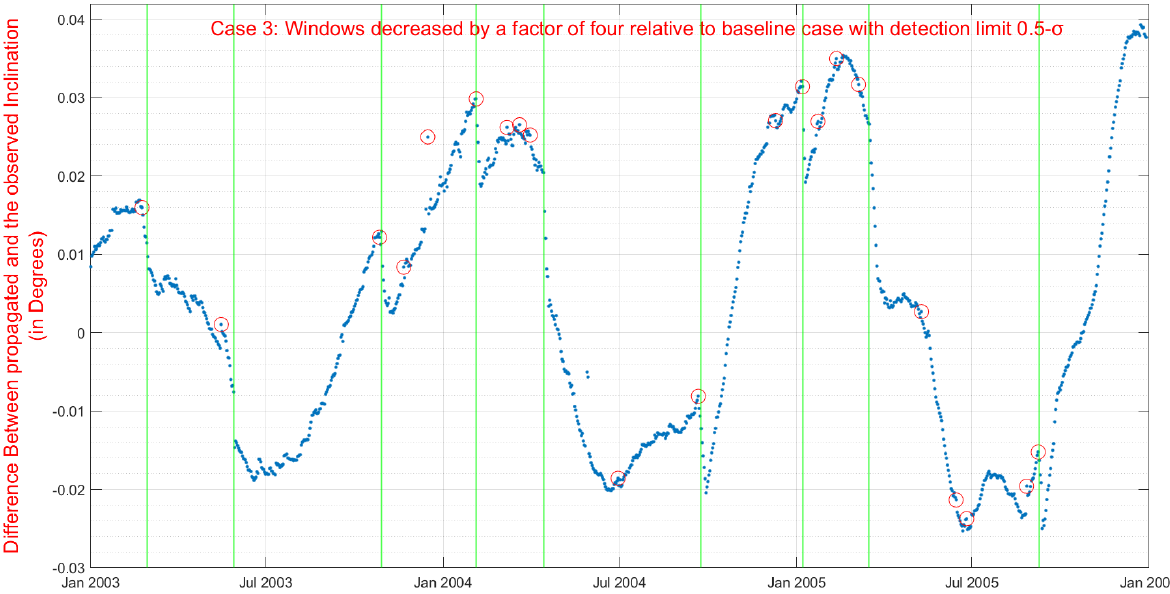
Figure 6. Case 3: Windows decreased by a factor of four relative to baseline case with detection limit 0.5-sigma. Vertical green lines represent the maneuvers and the red circles represent potential maneuvers detected by this